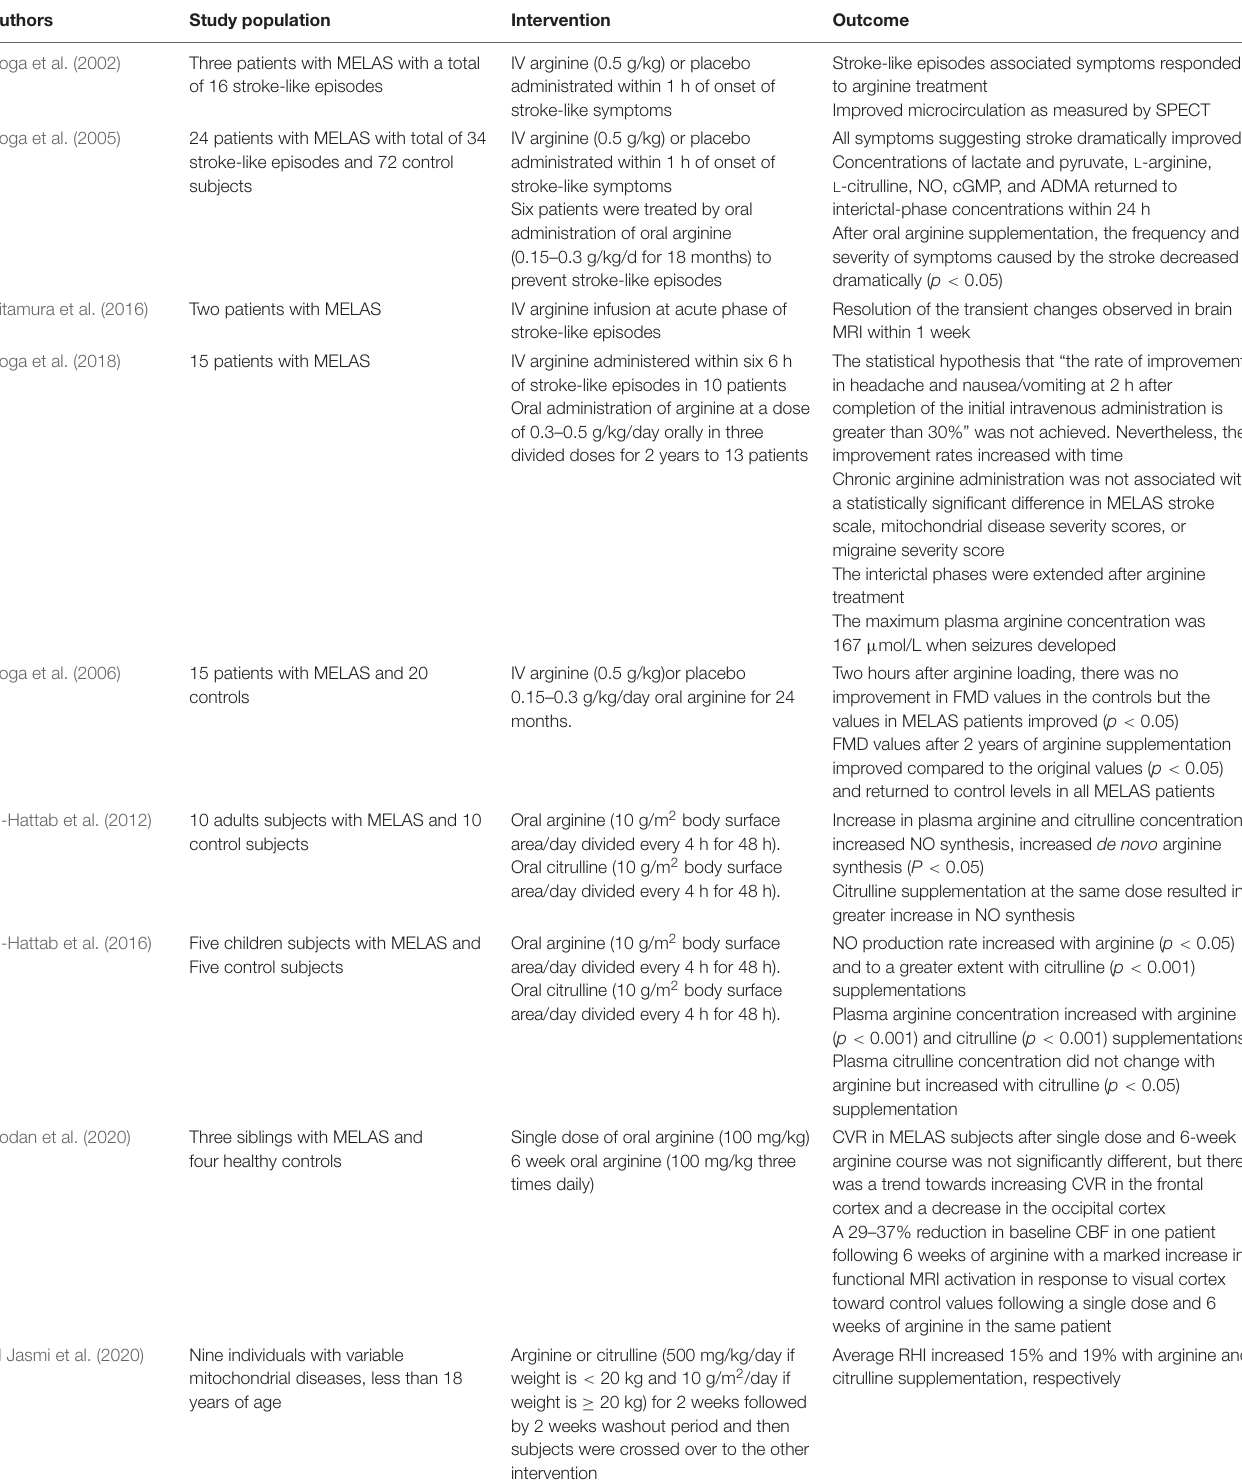
TABLE 1 | Summary of previous studies evaluating the use of Nitric Oxide precursors in patients with mitochondrial